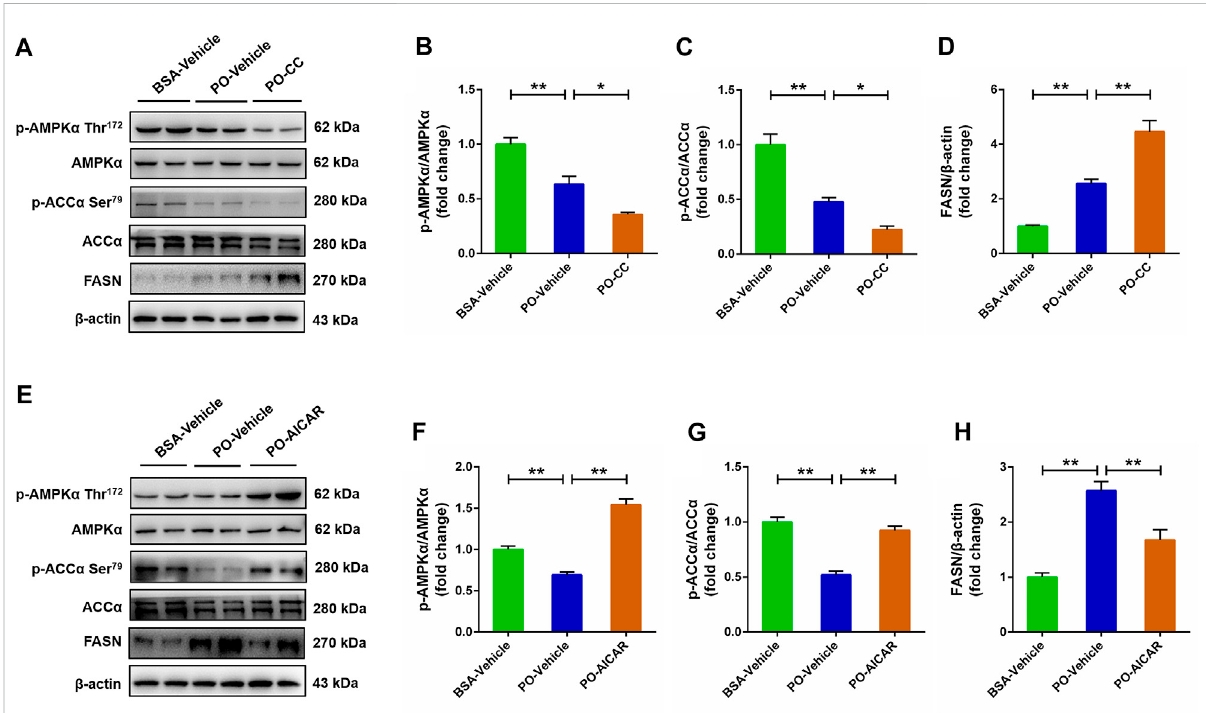
FIGURE 4 AMPK regulates the lipid synthesis related factors expression level in PO-stimulated primary chicken hepatocytes. The primary chicken hepatocytes werepre-treatedwith/without10 μ MAMPK inhibitorcompoundC for1h,and thenstimulatedwith/without0.75 mmolPO foranother 24 h. (A) ImmunoblotofphosphorylatedAMP-activatedproteinkinase α (AMPK α )(Thr172),AMPK α ,phospho( p )-acetyl-CoAcarboxylase α (p-ACC α ), ACC α and fatty acid synthase (FASN). (B) Statistical analysis of p-AMPK α (Thr172)/AMPK α ; (C) Statistical analysis of p-ACC α /ACC α ; (D) Statistical analysis of FASN/ β -actin. The primary chicken hepatocytes were pre-treated with/without 1 mM AMPK activator AICAR for 1 h, and then stimulated with/without 0.75 mmol PO for another 24 h. (E) Immunoblot of p-AMPK α (Thr172), AMPK α , p-ACC α , ACC α and FASN. (F) Statistical analysis of p-AMPK α /AMPK α ; (G) Statistical analysis of p-ACC α /ACC α ; (H) Statistical analysis of FASN/ β -actin. Values represent the means ± SE. * p < 0.05 and ** p < 0.01, signi fi cantly different between the indicated treatment